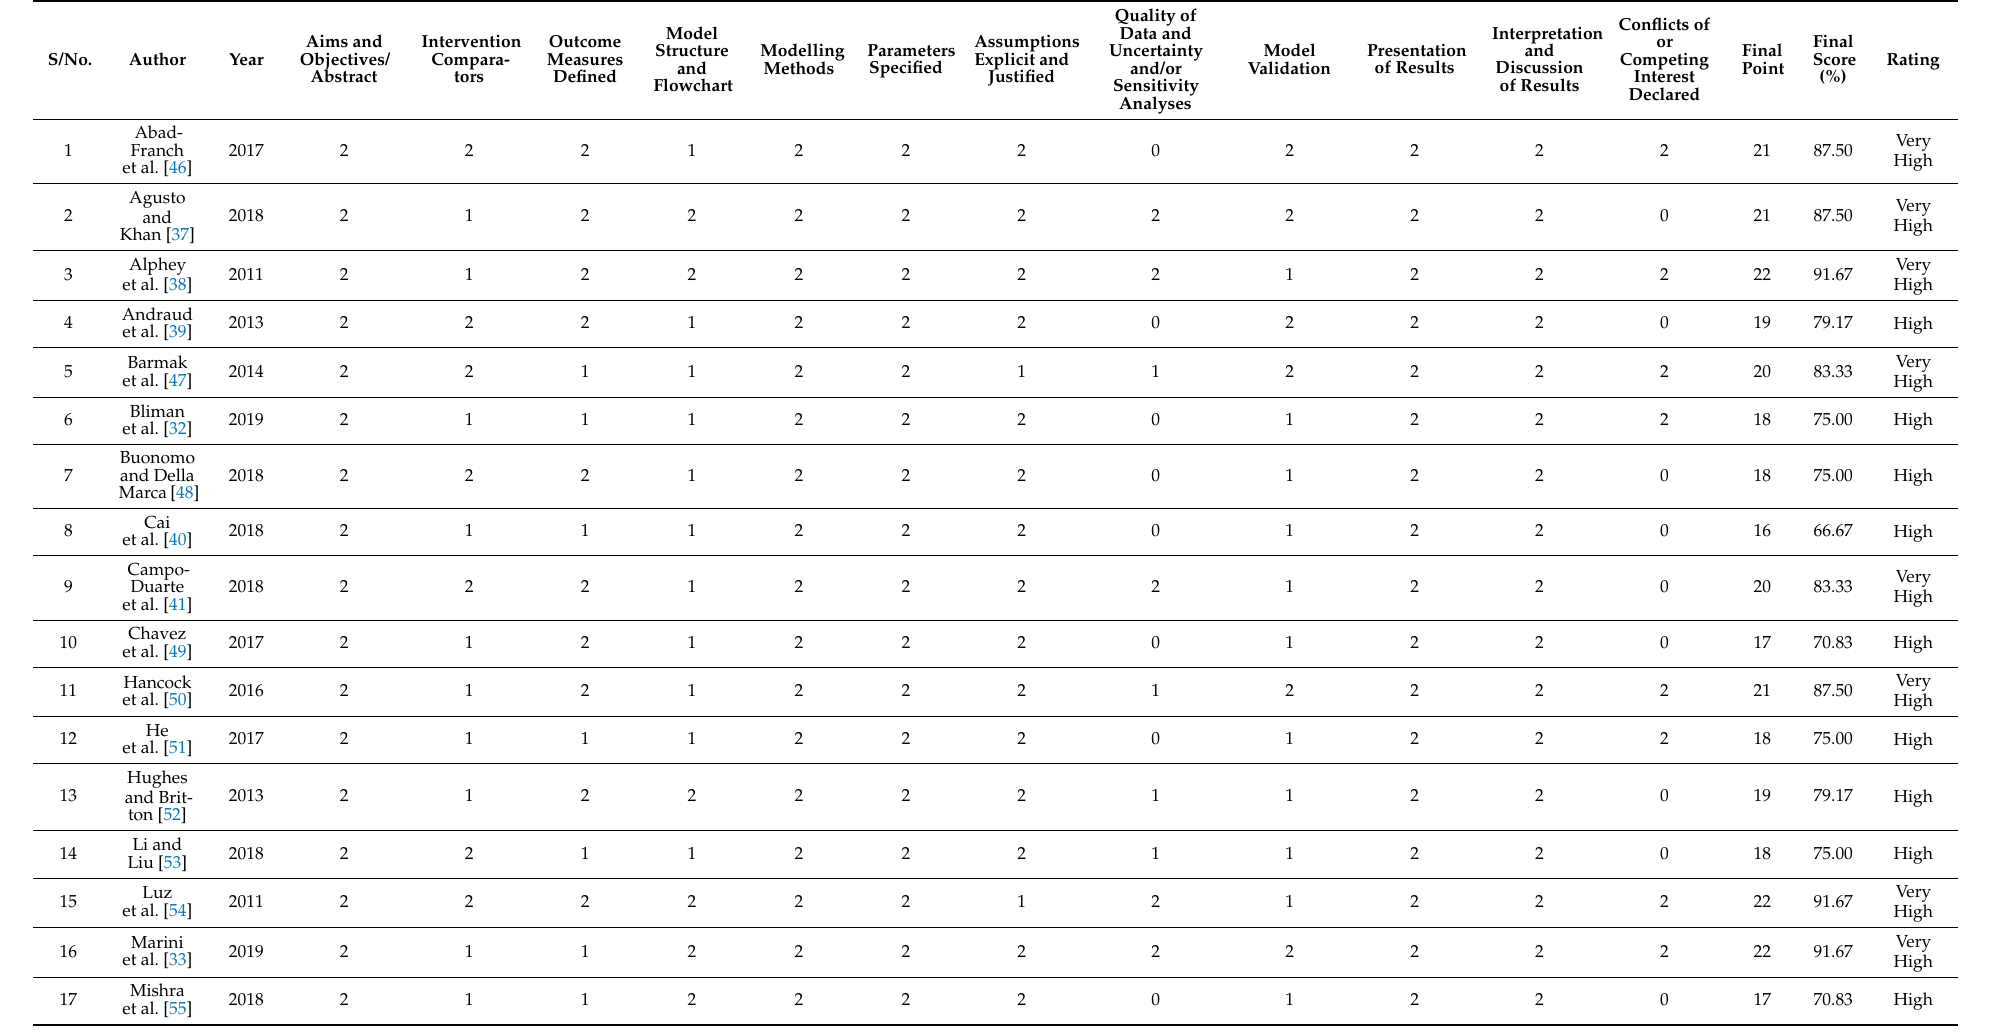
Table 2. Description of the quality assessment of the included studies adopting the tool Assessment for Modelling Studies (ASM). The values in the table below represent the AMS criteria 0 → absent, 1 → partially present, 2 → fully